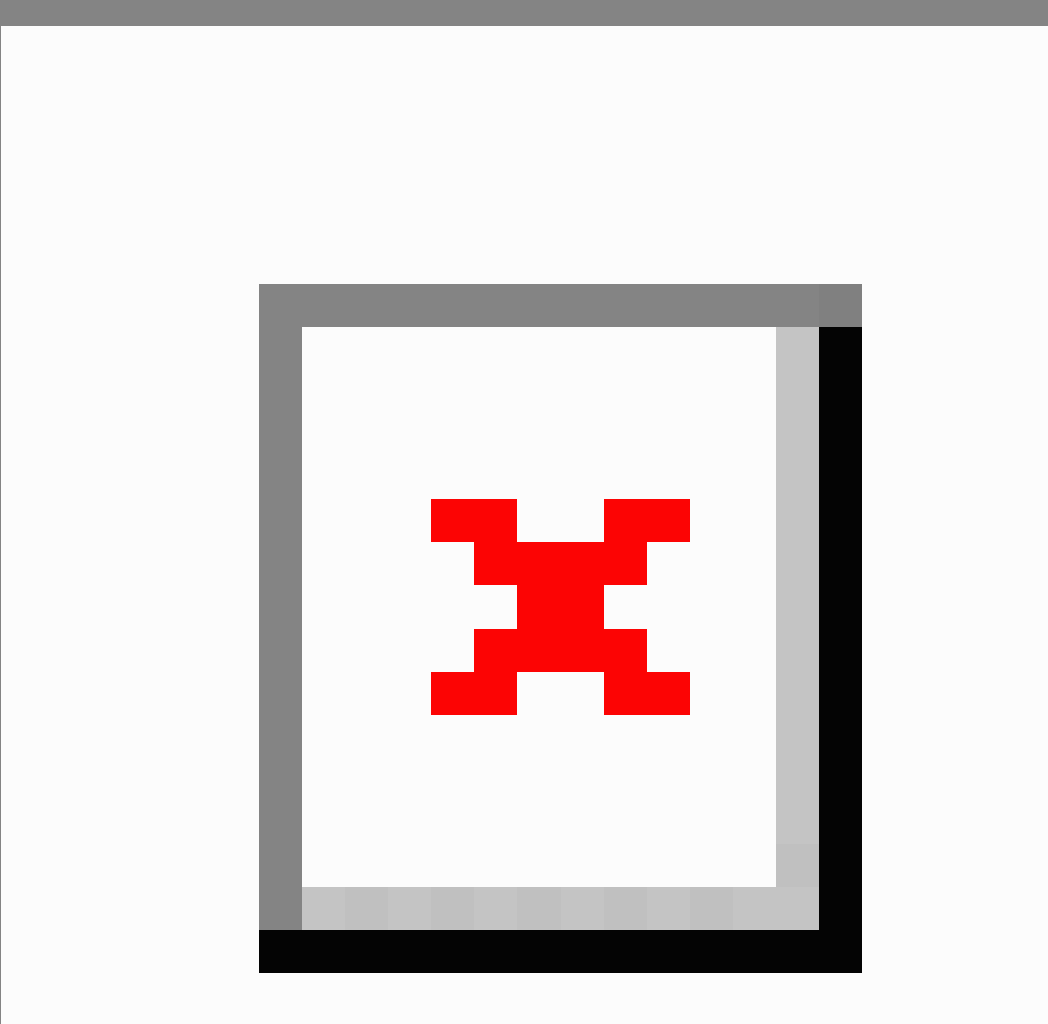
Figure 1. This is a diagram of the set-up for the iPod Touch free fall test showing the distance of travel of 100 cm. The i-Pod Touch is secured to a non-elastic string (blue arrow) to ensure that it is always held with the Z-axis in approximately -1G recording, corresponding to the screen facing upward, on the undersurface of the levelling